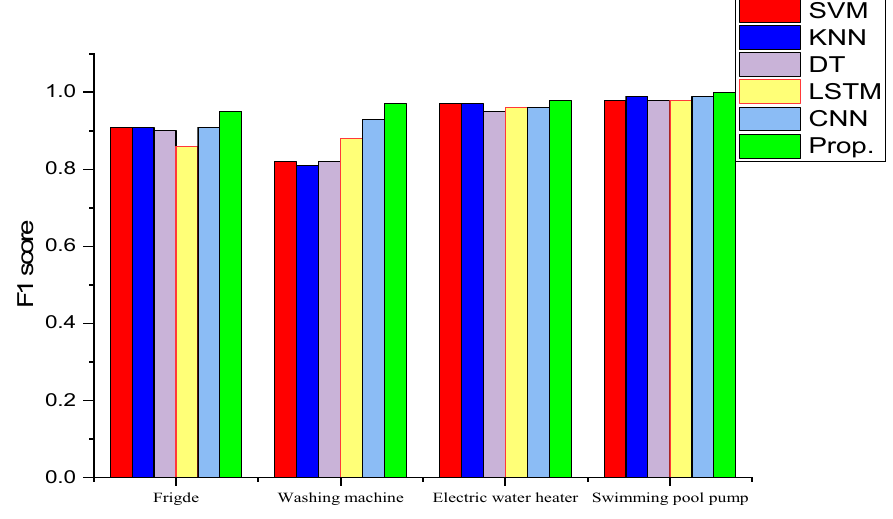
Figure 8. F 1 comparison.